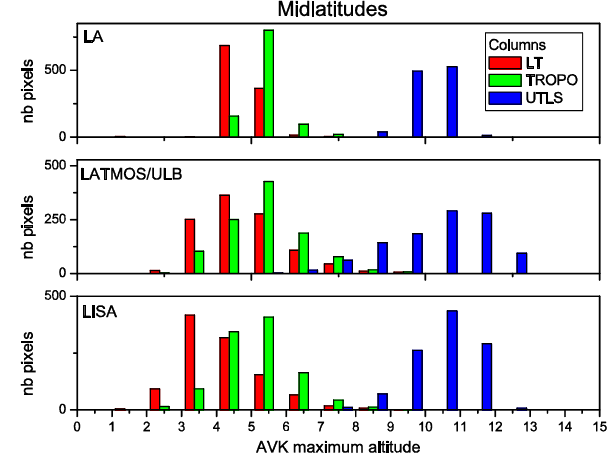
Figure 1. Distribution of the degrees of freedom of the LT, TROPO and UTLS partial columns of ozone given over the set of pixels selected for the validation. The distribution for the LA, LATMOS/ULB and LISA products are presented in the top, middle and bottom panels, respectively.